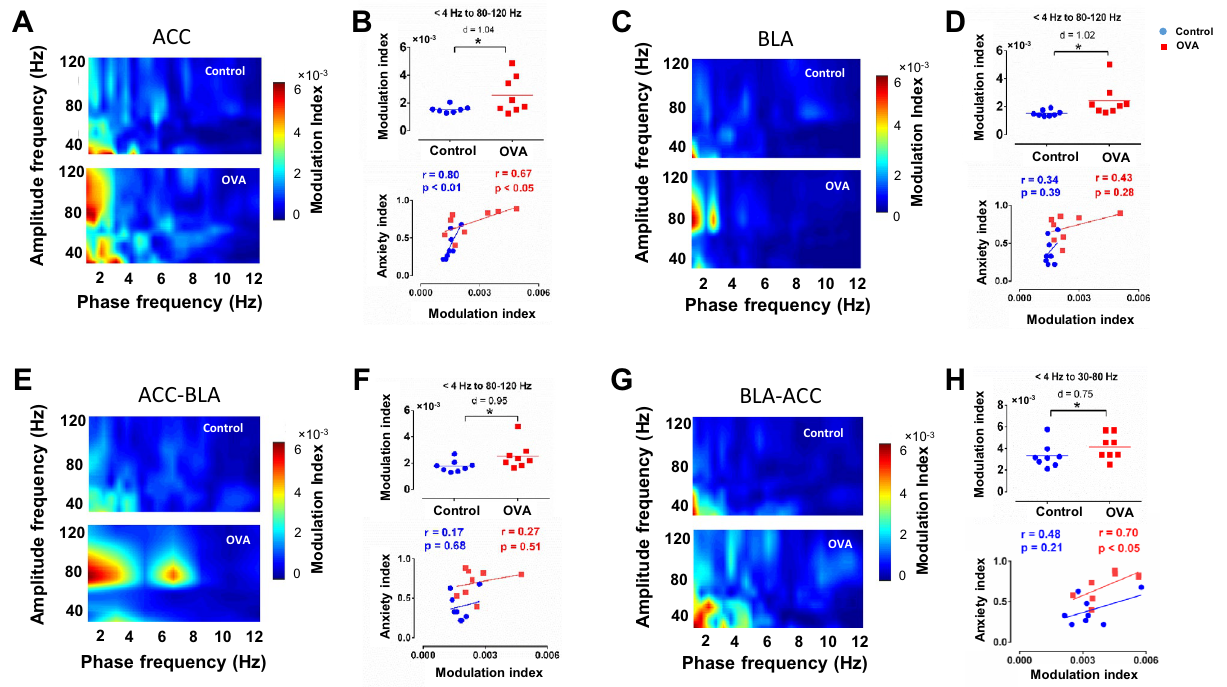
Figure 6. Phase-amplitude coupling within the ACC-BLA circuit. ( A, C, E, G ) Phase-amplitude comodugram of representative ACC ( A ), BLA ( C ), ACC-BLA ( E ), and BLA-ACC ( G ). ( B, D, F, H ; upper panels) Peak modulation index across phase frequencies computed for gamma amplitude in ACC ( B ), BLA ( D ), ACC-BLA ( F ), and BLA-ACC ( H ). The horizontal bars indicate mean values. ( B, D, F, H ; upper panels) Correlation between anxiety index and PAC of ACC ( B ), BLA ( D ), ACC-BLA ( F ), and BLA-ACC ( H ). Correlation coefficient (r) was performed using Pearson correlation coefficient analysis. Data were computed by t-test, n = 8 per group. *p < 0.05 compared to control. OVA, ovalbumin; ACC, anterior cingulate cortex; BLA, basolateral amygdala; PAC, phase-amplitude